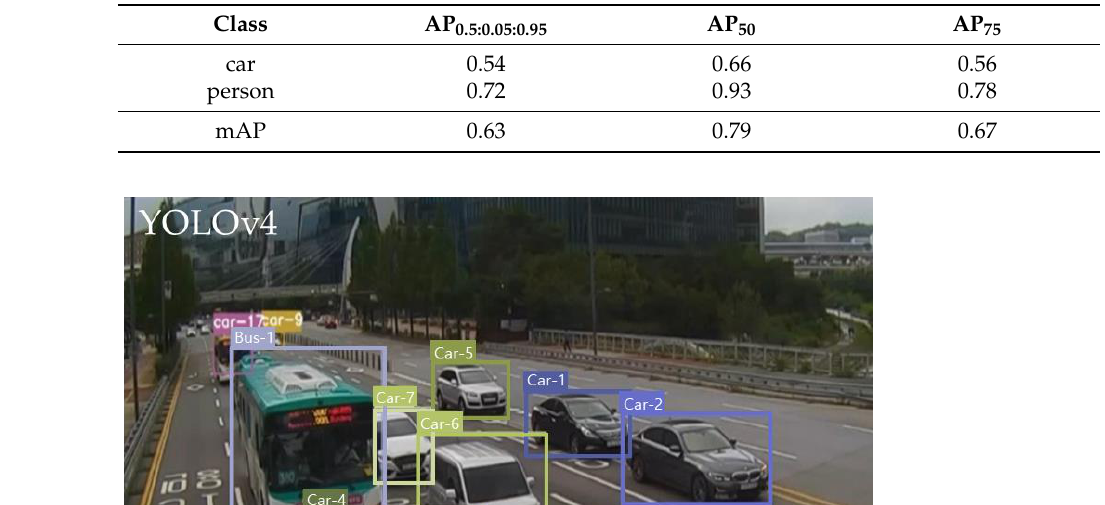
Table 2. Results of detection using our model.